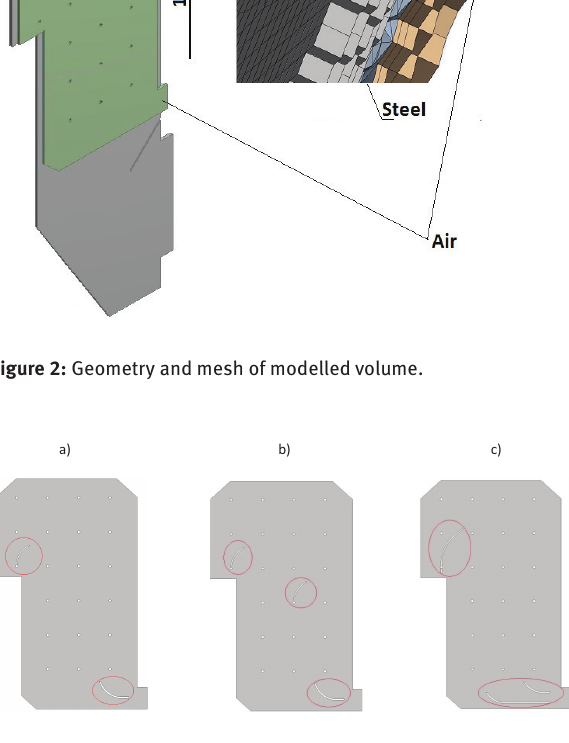
Figure 3: The modified heat exchanger a) two baffles (location of upper and bottom baffles is the same as in the exchanger with one baffle), b) three baffles – version 1, c) three baffles – version 2.